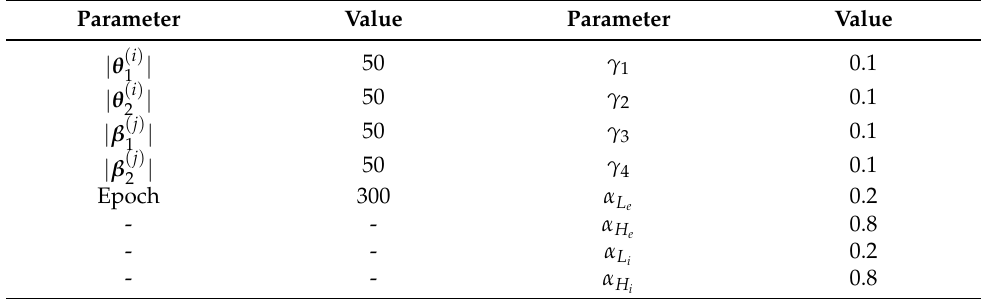
Table 1. Values of tuning